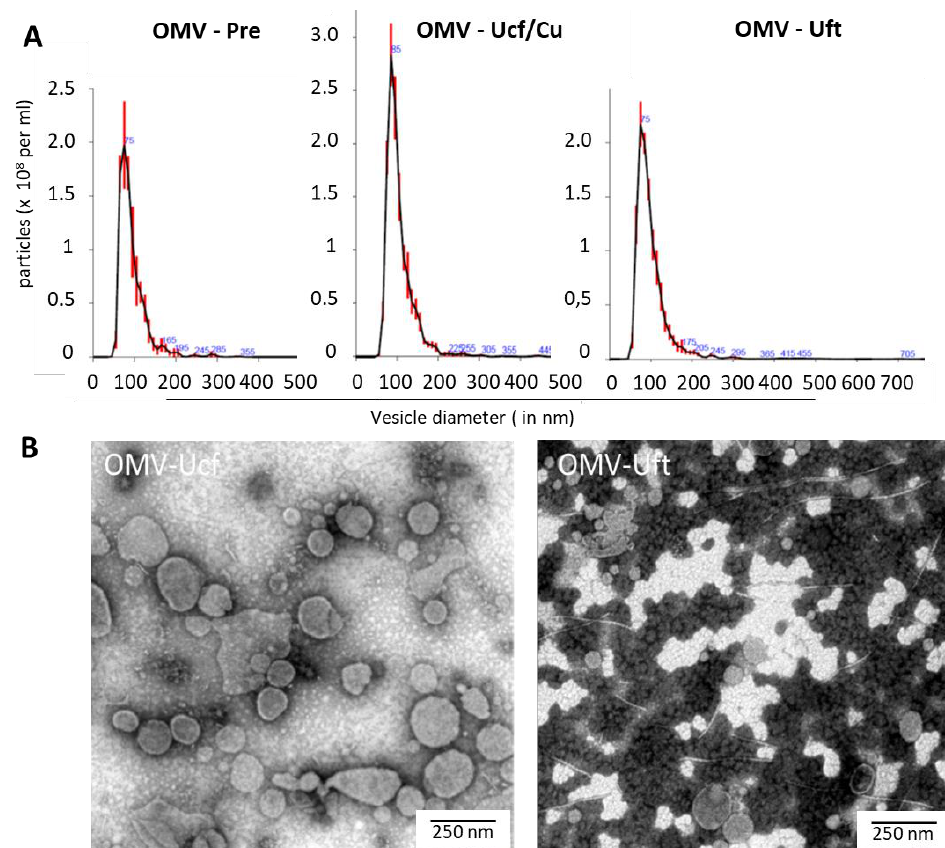
Figure 1. Biophysical characterization of OMVs. ( A ) The graphs show results from nanoparticle tracking analysis (NTA). The curves indicate the size distribution of particles in the samples purified by ultracentrifugation (Uct) and ultrafiltration (Uft). Material before final purification is also shown (Pre). The maximum indicates the mode of vesicle diameters. The blue numbers indicate local maxima. ( B ) The images show transmission electron micrographs of OMV preparations Light filamentous structures in the right micrograph indicate flagella debris. For quantitative analysis see Table 2. Table 1. Nanoparticle tracking analysis—diameter and concentration.